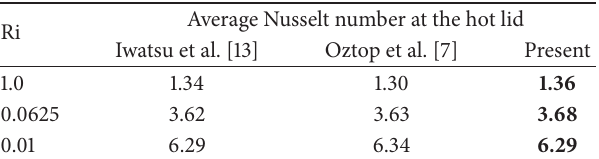
Table 3: Comparison of Nu at the hot lid between the present results and those reported in the